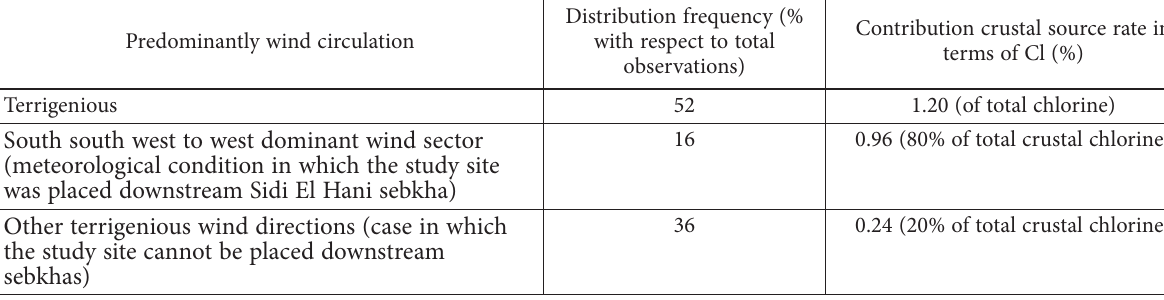
Table 8. Estimated crustal source contribution rate in terms of chlorine (S14)